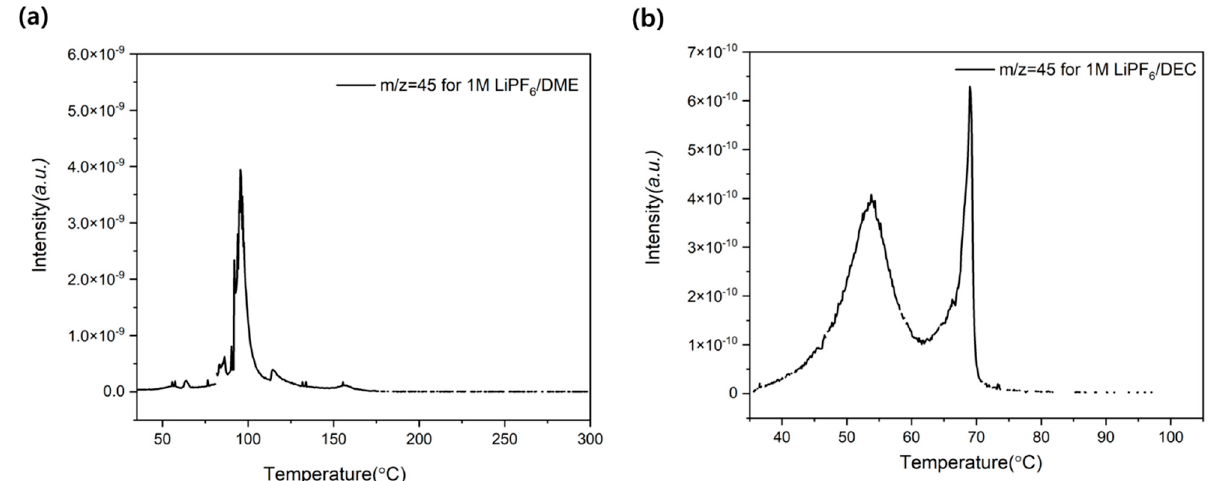
Figure 3. ( a ) Mass spectral peak of FCN ( m / z = 45) in 1 M LiPF 6 /DME and ( b ) mass spectral peak of FCN ( m / z = 45)1 M LiPF 6 /DEC electrolyte.